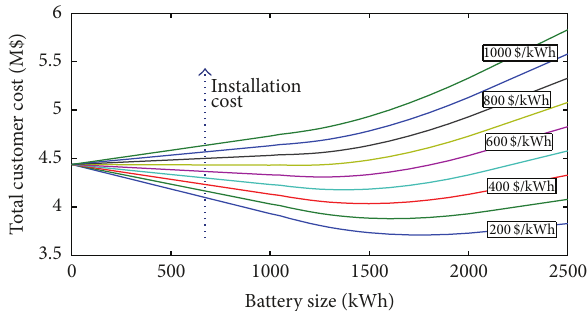
Figure 6: Total customer cost with 𝛼 = 5 %, 𝛽 = 5 %, 𝜂 = 98 %, for 5% annual load variations (industrial load). 𝜂 dch